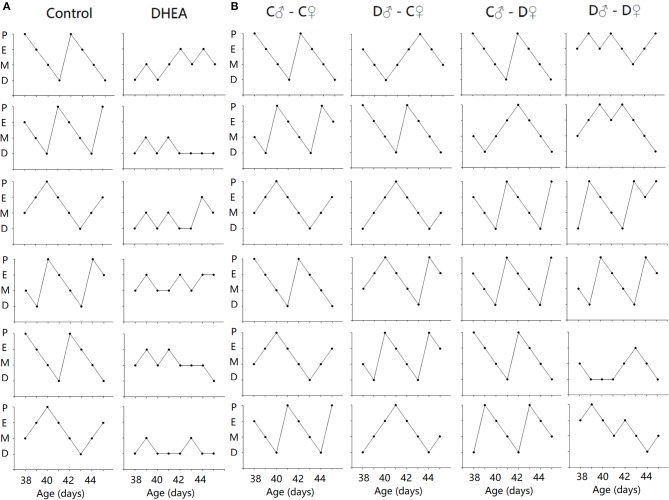
Disrupted estrus cycles in F1 (A) and F2 (B) female offspring. Six sample cycles were shown for each group. y axis: P, pro-estrus; E, estrus; M, metestrus; D, diestrus. x axis: C: control; D: DHEA.